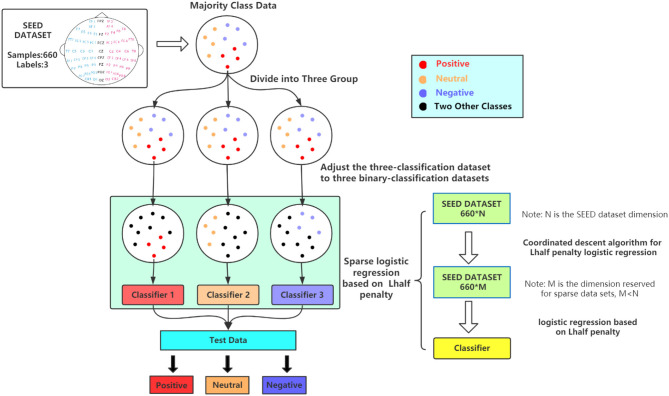
Flow chart of sparse logistic regression based on L1/2 penalty. First, we divide a three-category dataset (such as SEED) into three two-category datasets (the upper part). Next, the green part represents training a classifier based on L1/2 penalty logistic regression for each binary classification dataset. Each classifier will reduce the sample dimension from N to M after sparsification. For each input EEG data, we will get three binary classification results. Through summary analysis, the final three classification results are obtained.